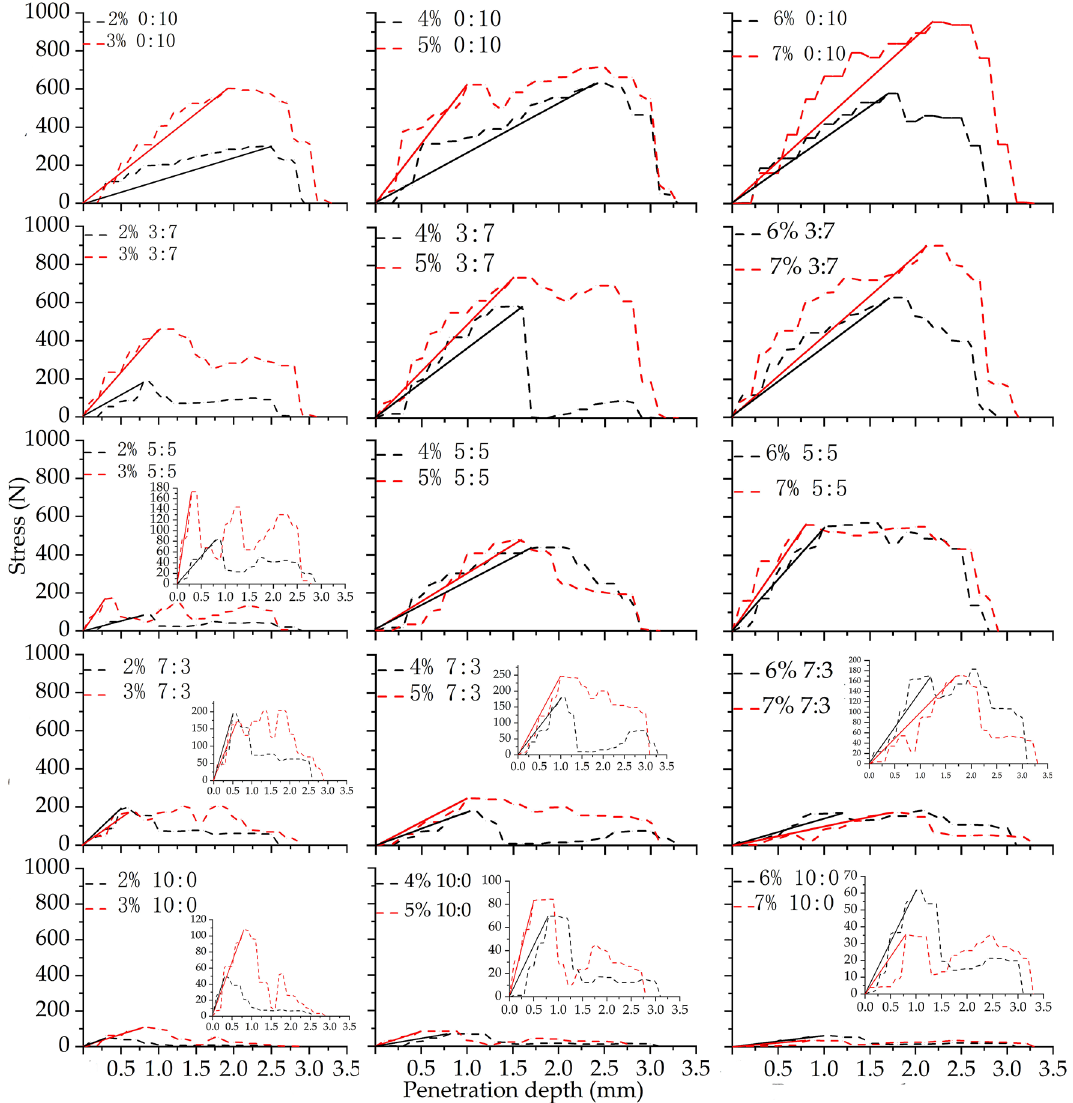
Figure 4. Curves of stress and penetration depth. Percentage represents the salt content, and the proportion represents ratio of sodium sulfate to calcium chloride. For example, 2% 0:10 indicates that the salt content of the sample is 2% and that the mixed salt ratio (sodium sulfate:calcium chloride) is Figure 5 shows that the sodium sulfate crystal is transparent. The crystal of sodium sulfate grows on the surface of sandy soil and wraps around the sandy soil. With the growth of crystals, the pores of the soil are filled with salt crystals. On the soil surface, the crystals form a flake structure with a certain texture, and some crystals gather to form larger salt crystal particles. The calcium chloride crystal is a grayish-white small-volume crystal, and it is adsorbed on the surface of sandy soil particles. When the sand particles are completely coated by calcium chloride crystals, the color of the surface of the sample turns gray-white. The crystals of calcium chloride and sodium sulfate cement aeolian soils in completely different ways. Crystals of calcium chloride are absorbed on the surface of aeolian soil particles, and the parti- cles absorbing the crystals of calcium chloride are still independent. With an increase in the number of calcium chloride crystals on the surface of soil particles, the number of soil salt cementing particles increases continu- ously, finally causing the particles to aggregate to form a stable soil salt crust. Sodium sulfate crystals crystallize in the pores of sandy soil. The crystals of sodium sulfate aggregate to form large crystals and then wrap around the upper surface of the particles of sandy soil, forming a soil salt crust. Mixed salts can also produce sodium chloride and calcium sulfate crystals. In Fig. 5, we observed not only sodium sulfate and calcium chloride crystals but also sodium chloride crystals, which are silver-white cubic crystals. Desarnaud 28 studied the nucleation and growth of sodium chloride crystals from a molecular point of view and found that sodium chloride crystals grew on the surface of polyvinylidene fluoride (PVDF) and formed a cubic lattice structure. According to the crystal morphology in Fig. 5 and Eq. (1) in the paper, the crystals can be